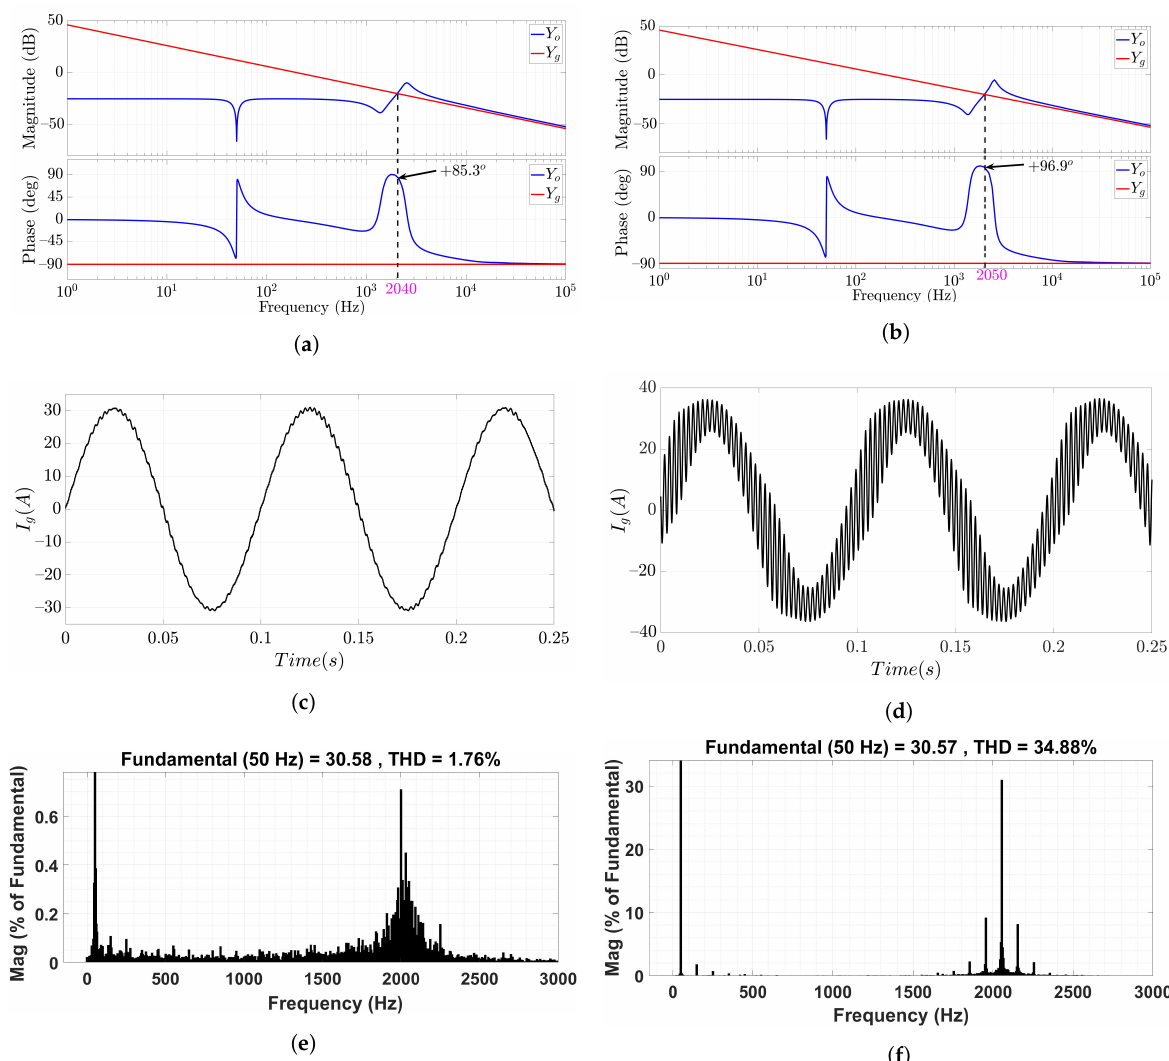
Figure 9. Stable ( a , c , e ) and unstable ( b , d , f ) cases of a single inverter connected to the grid. ( a , b ) Bode plot of Y o and Y g . ( c , d ) Simulation results of the grid current waveforms. ( e , f ) Harmonic spectrum of grid